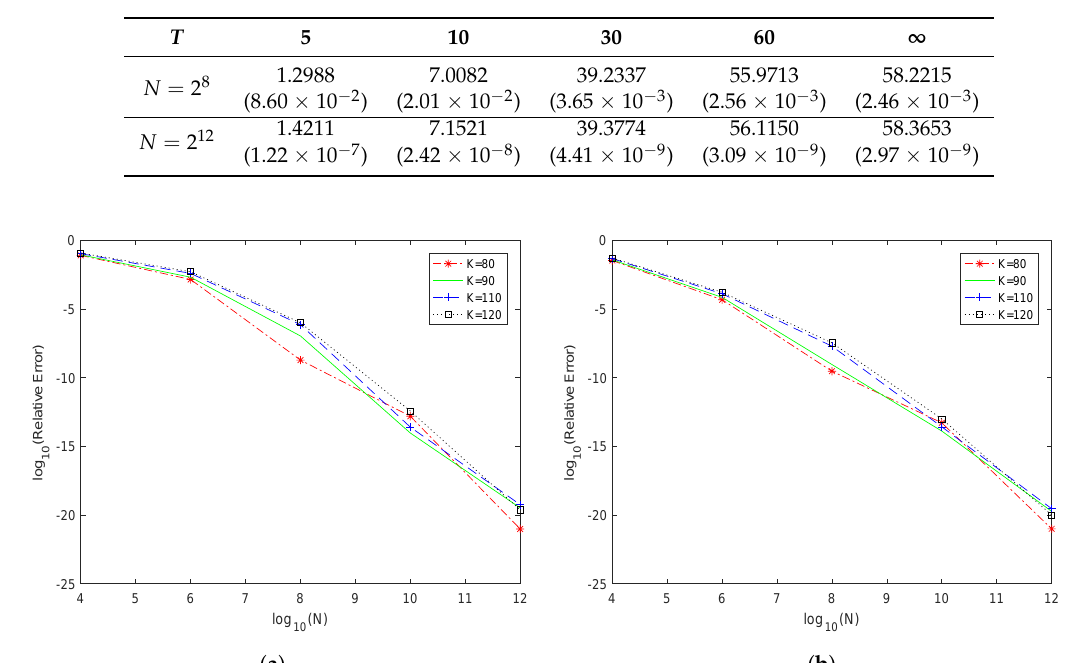
Table 7. Approximation results for finite GMDB, where X is BS, b ( s ) = ( s − K ) + and K = 120.